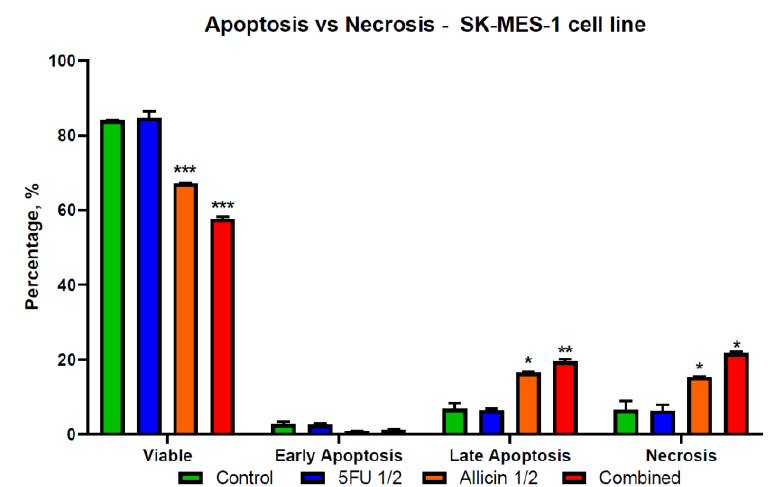
Figure 9. The illustration of apoptosis and necrosis in the SK-MES-1 cell population. SK-MES-1 cell line ratio between viable, apoptotic, and necrotic cells, with an increased number of late apoptotic and necrotic cells. The graphics were analyzed using Prism8 software. Abbreviations: Control, control group; 5-FU 1 / 2, half of the 5-FU IC 50 -treated group; Allicin 1 / 2, half of the Allicin IC 50 -treated group; Combined, the co-treatment group. The results with p < 0.05 were considered statistically significant (* p < 0.05, ** p < 0.01, and *** p < 0.001).